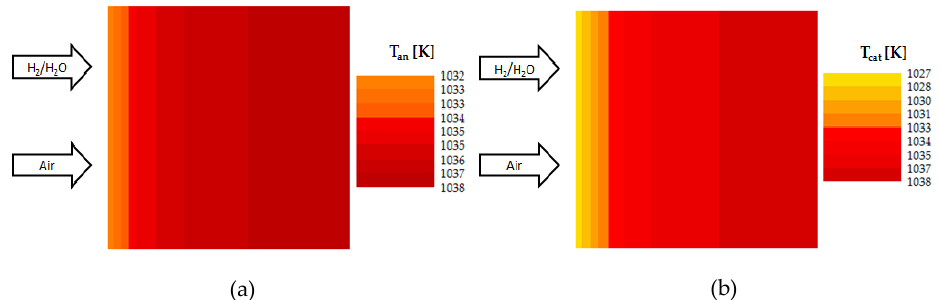
Figure 6. Maps in co-flow feeding configuration at inlet conditions of 1023 K with H 2 /H 2 O 97/3 and air: ( a ) anodic and ( b ) cathodic gas temperature [K] in Pt-mesh cell.